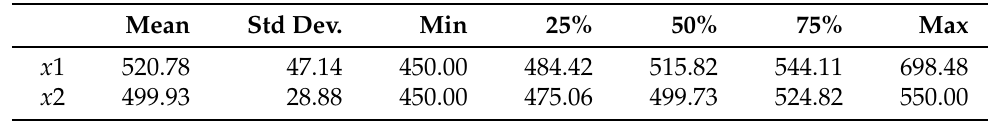
Table A1. Descriptive statistics of the synthetic data set, the statistics include: Mean value (mean), standard deviation (std dev.), minimal value (min), 25th percentile (25%), 50th percentile (50%), 75th percentile (75%), and maximal value (max).